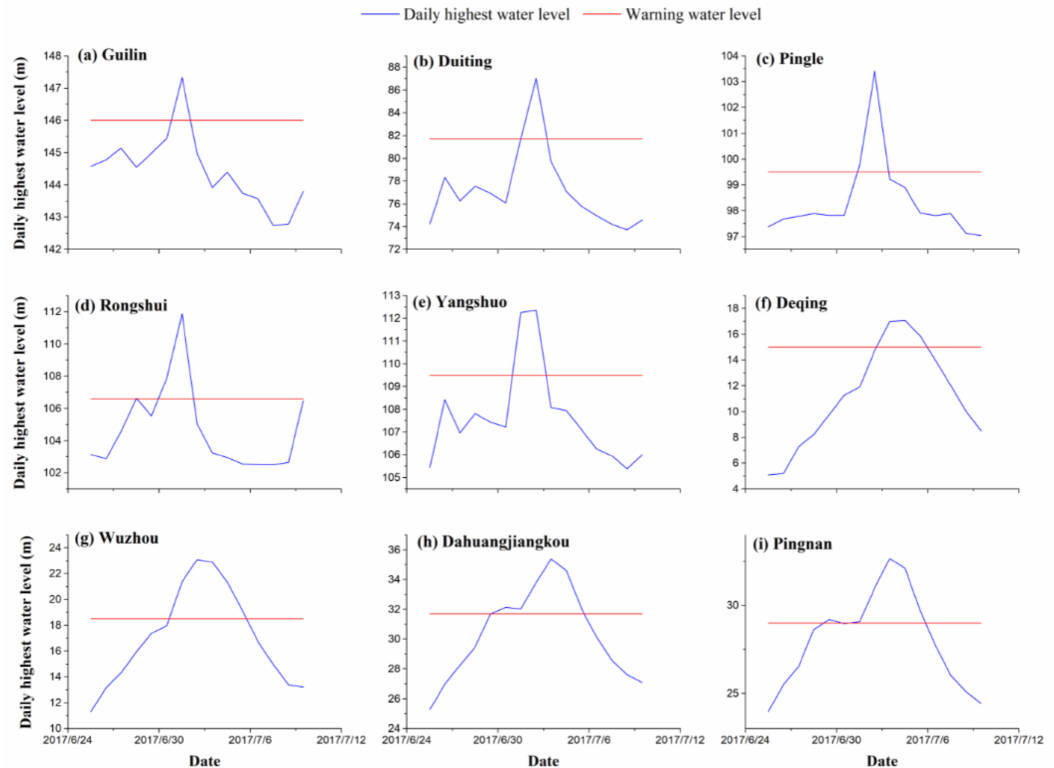
Figure 11. The daily highest water level at some key hydrological Stations during the 2017 flood. ( a ) Guilin Station; ( b ) Duiting Station; ( c ) Pingle Station; ( d ) Rongshui Station; ( e ) Yangshuo Station; ( f ) Deqing Station; ( g ) Wuzhou Station; ( h ) Dahuangjiangkou Station; ( i ) Pingnan